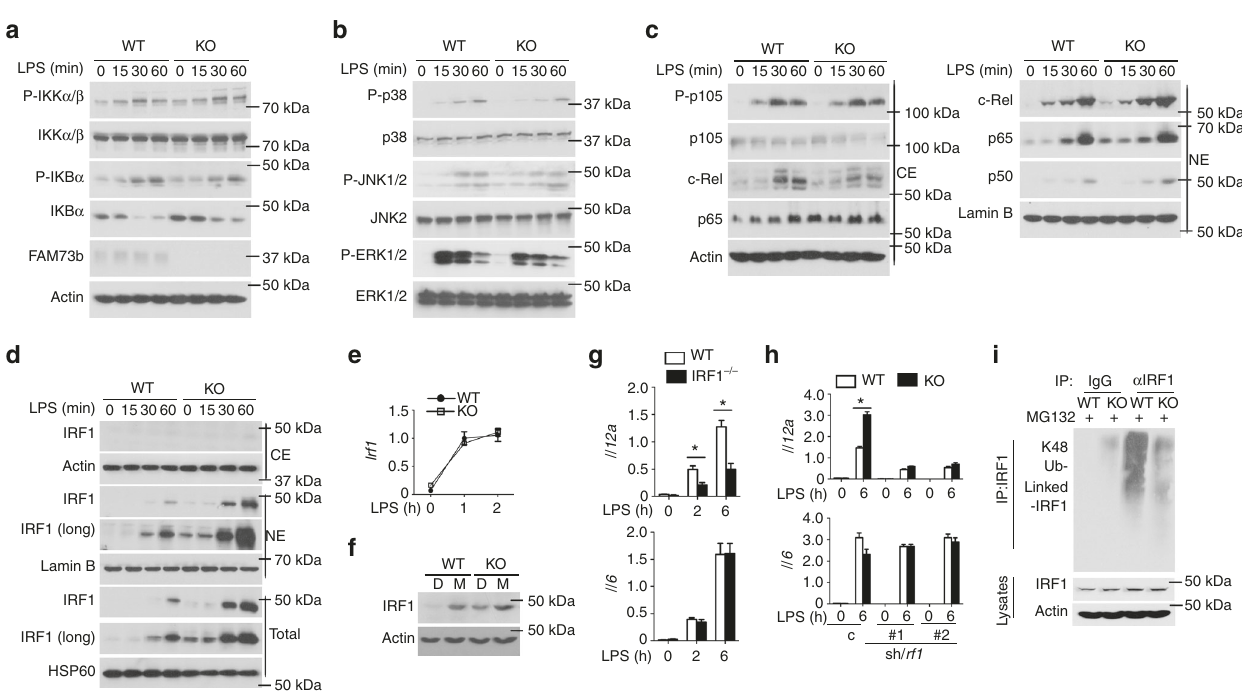
Fig. 5 FAM73b de fi ciency promotes IRF1 stability. a – c The indicated proteins in whole-cell lysates ( a , b ) or cytoplasmic (CE) and nuclear (NE) extracts ( c ) of WT and FAM73b KO BMDMs were measured by IB analysis. d IB analysis of the IRF1 level in LPS-stimulated WT or FAM73b KO BMDMs. qRT-PCR analysis of Irf1 in WT or FAM73b KO BMDMs ( e ). IB analysis of the IRF1 levels in BMDMs after pretreatment with DMSO or MG132 for 30 min before harvest ( f ). g Il12a and Il6 mRNA levels were evaluated by qRT-PCR. h WT and FAM73b KO BMDMs infected with pGIPZ lentiviral vectors encoding a non- silencing control shRNA (C) or two different Irf1 -speci fi c shRNAs. qRT-PCR analysis of the indicated genes. The data are presented as the fold-induction relative to the Actb mRNA level. i WT and FAM73b KO BMDMs were stimulated with LPS for 60 min and incubated with MG132 for 30 min. IRF1 was isolated by IP (under denaturing conditions), and its ubiquitinated form was detected by IB using anti-K48-linked ubiquitin antibody. Protein lysates were also subjected to direct IB (bottom panels). Similar results were obtained in three independent experiments. Two-tailed unpaired t-tests were performed; * P <